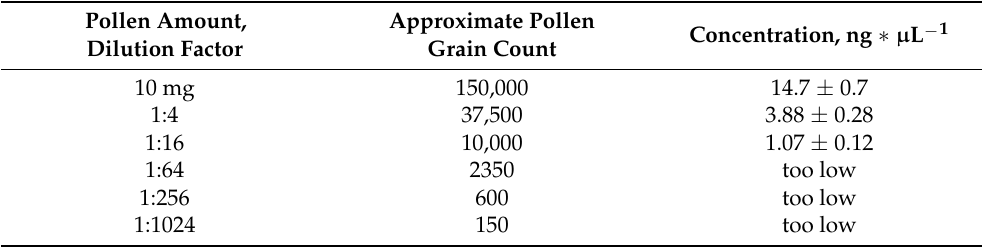
Table 4. Pollen DNA extraction test